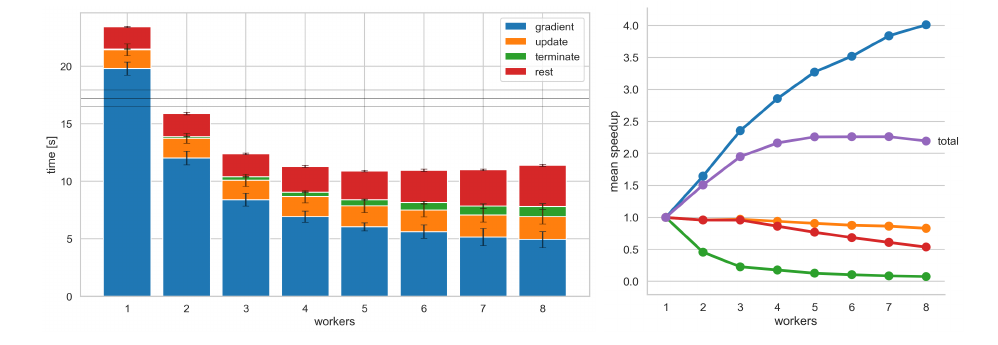
Figure 1: Fast model wall clock run times for runs with increasing number of workers on the horizontal axis. For each number of workers, the fit was repeated 10 times to get both mean run time — indicated by the height of the bars — and standard deviation — indicated by the black error bars on each histogram bar. Separately measured components of the run time are colored as indicated in the legend: gradient calculation time, update time of parameters between processes, terminate time at the end of a run (shutting down ZeroMQ sockets and context and the forked processes) and the rest of the run time (in these runs this includes the line-search phase). For reference, the black horizontal line at about 17 seconds indicates the mean run time of the old RooFit::RooMinimizer class, while the surrounding two grey lines indicate those runs’ standard